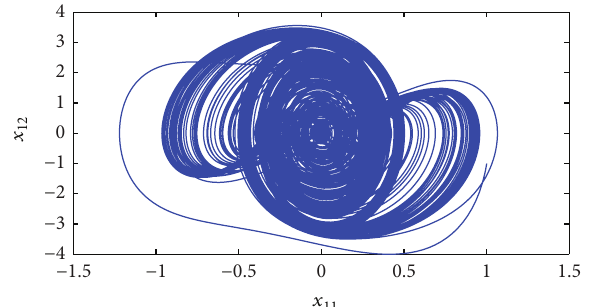
Figure 5: Behaviors of the chaotic gyros: (a) trajectories of 𝜃 of the chaotic gyro, (b) trajectories of